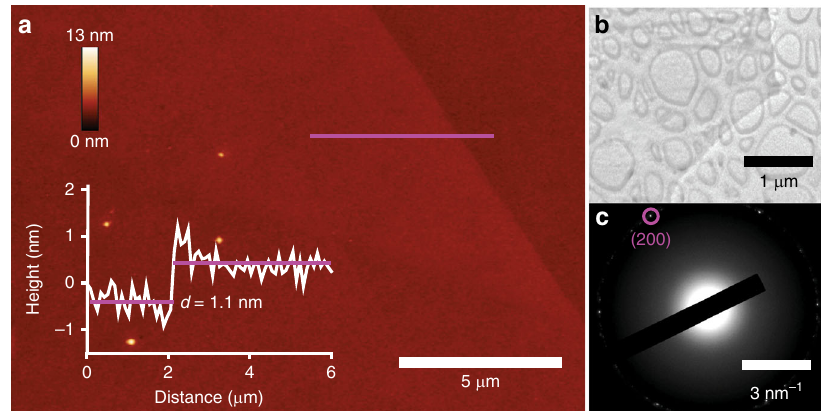
Fig. 2 Morphology and TEM characterisations of the printed 2D GaPO 4 fi lm. a AFM topography of a GaPO 4 nanosheet and height pro fi le along the magenta line. b TEM micrograph of the GaPO 4 fi lm. c The SAED pattern of the TEM micrograph